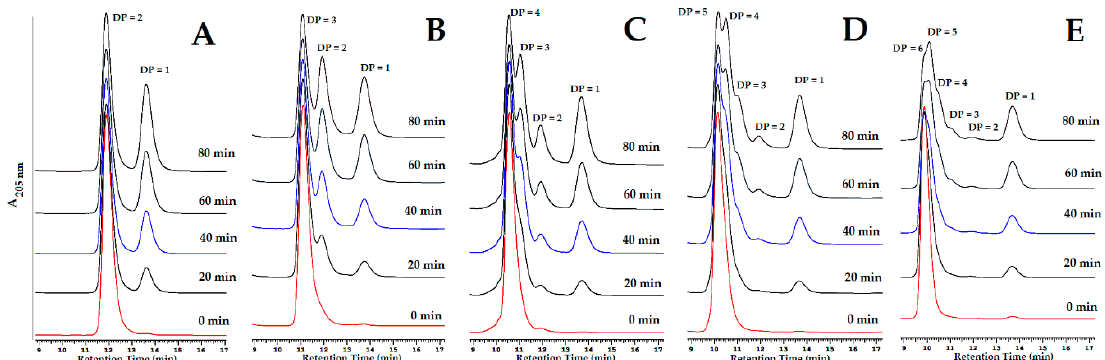
Figure 6. HPLC analysis of the hydrolysis products from (GlcNAc) 2–6 by TKU048 exochitinase. A – E : (GlcNAc) 2 –(GlcNAc) 6 , respectively. The reaction was conducted by adding 500 µL substrate solution (0.5 mg/mL) with 500 µL enzyme solution (2 U, approximately) and incubated at 50 °C. Twenty microliters of sample was used for a single HPLC analysis.